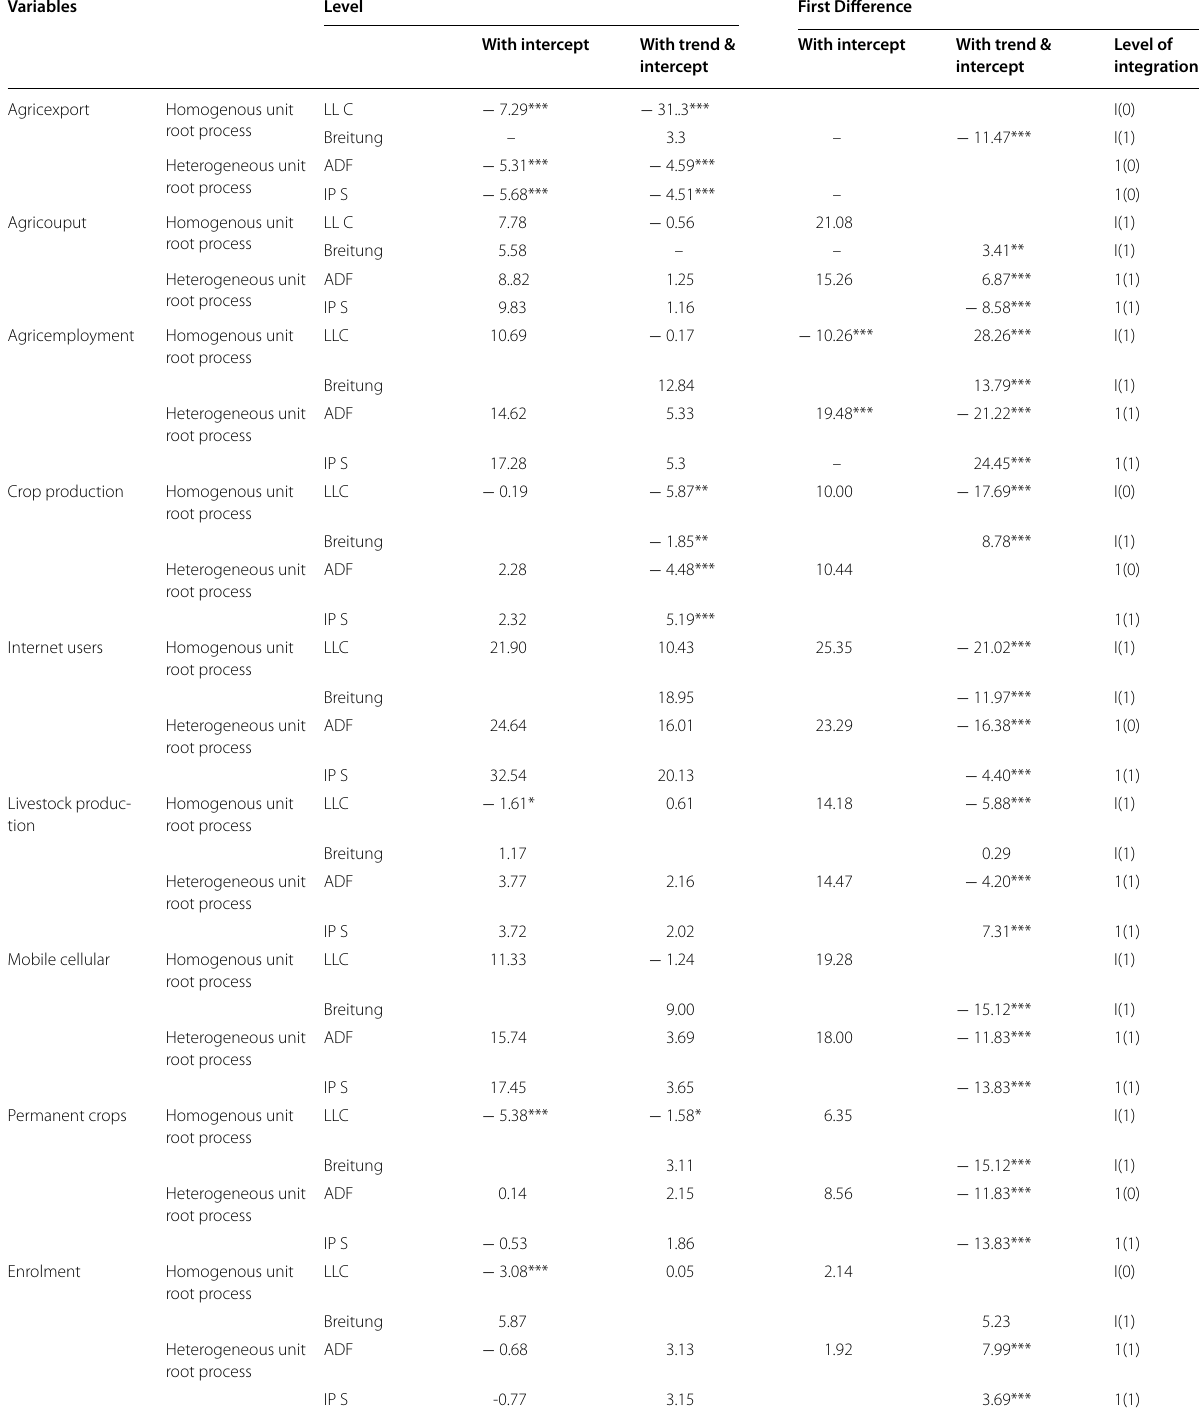
Table 3 Unit root test